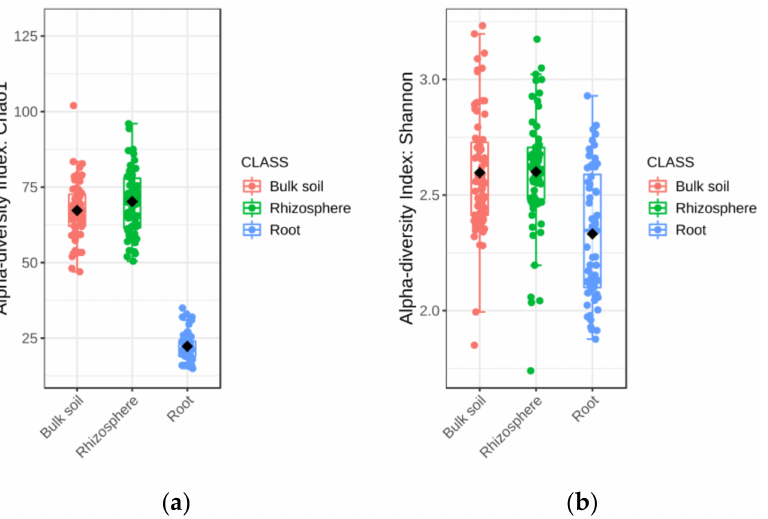
Figure 1. Boxplot illustrating the differences in ( a ) Chao1 and ( b ) Shannon diversity measures of the fungal communities in the soil-plant compartments.